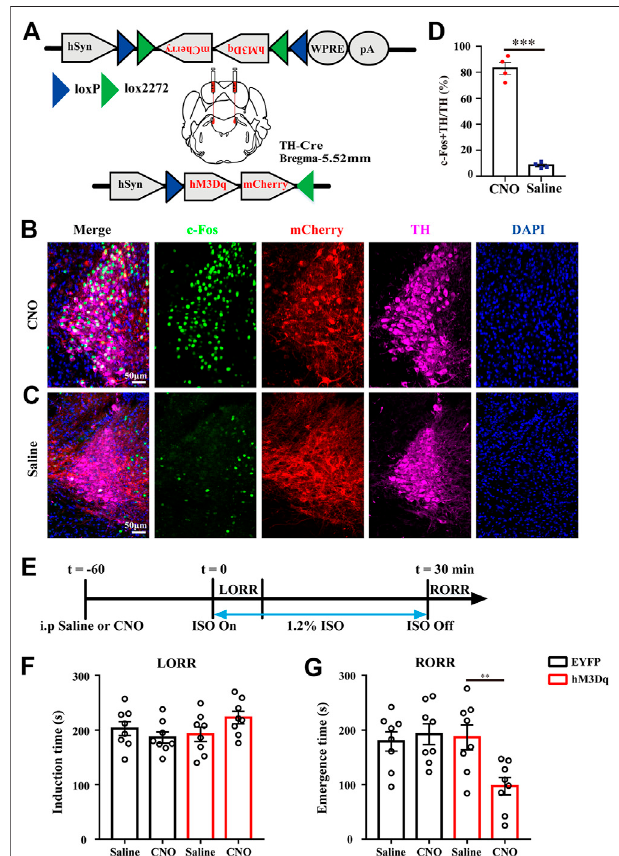
FIGURE 2 | LC TH neurons activation facilitates emergence from anesthesia. (A) Schematic diagram showing the injection target of LC in TH- Cre mice and representation of hM3Dq vectors injected under control of the hSyn promoter. (B,C) Representative images showing the co- localization of c-Fos (green), TH (purple) and mCherry (red) in LC of hM3Dq micetreated withCNO (B) orsaline (C) . (D) Thepercentage ofc-Fos+TH/TH in the LC of hM3Dq mice injected i. p. with CNO or saline ( n (cid:1) 4 in each group, the two-tailed unpaired t-test, *** p < 0.001). (E) Timeline for measuring inductionandemergencetimeinhM3Dqmiceinjectedi.p.withCNOorsaline. (F) Induction time with exposure to 1.2% iso fl urane after injected i. p. with saline or CNO of EYFP (black) and hM3Dq (red) mice, respectively ( n (cid:1) 8 in eachgroup,two-wayRMANOVAwithTukey ’ smultiplecomparisonstest). (G) Emergence time with exposure to 1.2% iso fl urane after treatment with saline or CNO of EYFP (black) and hM3Dq (red) mice, respectively ( n (cid:1) 8 in each group, two-way RM ANOVA with Tukey ’ s multiple comparisons test, ** p < 0.01). Data shown as means ±